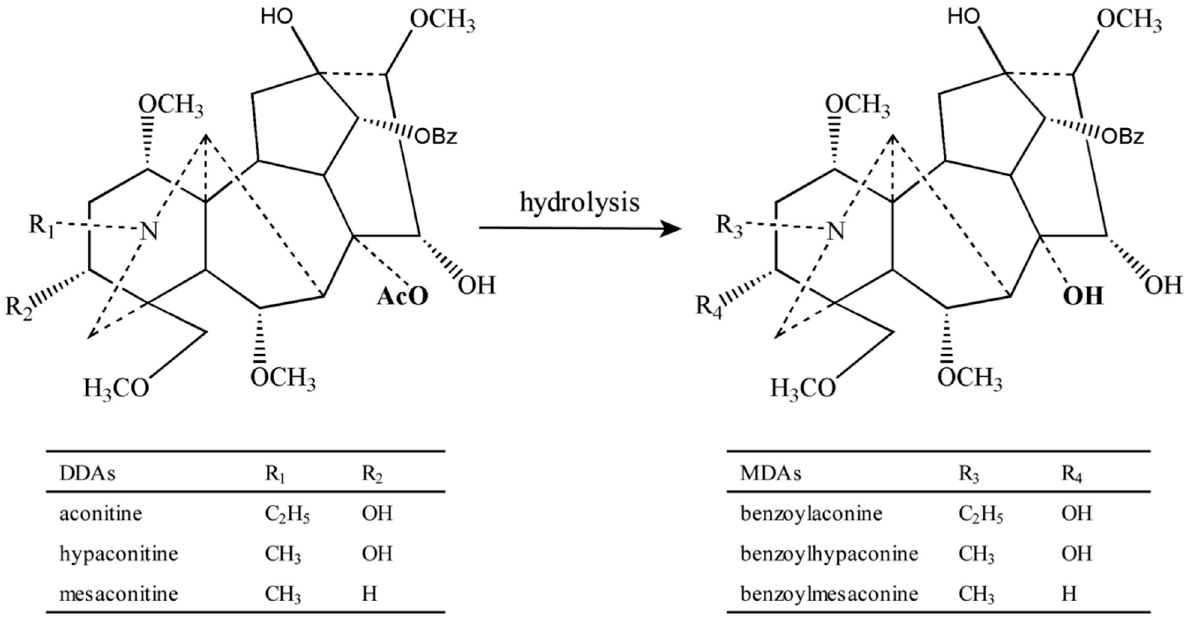
Figure 2. Chemical structures of the six aconitum alkaloids, and the reaction from DDAs to MDAs.